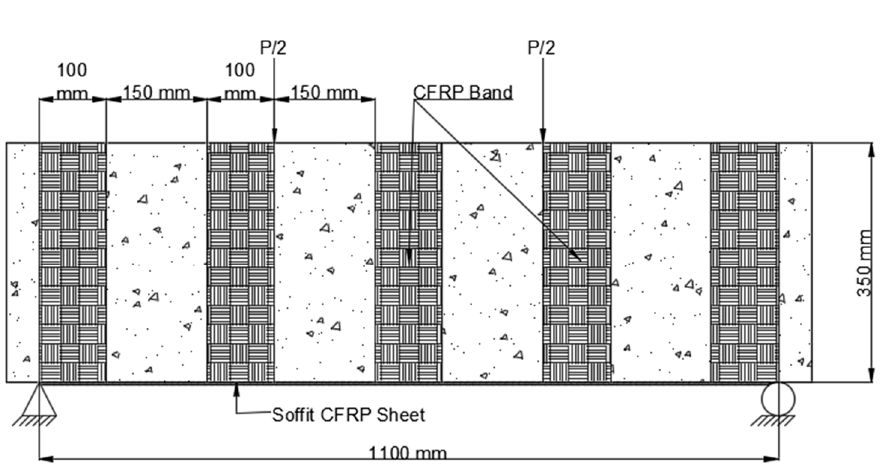
Figure 8. Placement of CFRP on beam Scheme 1 (B1).